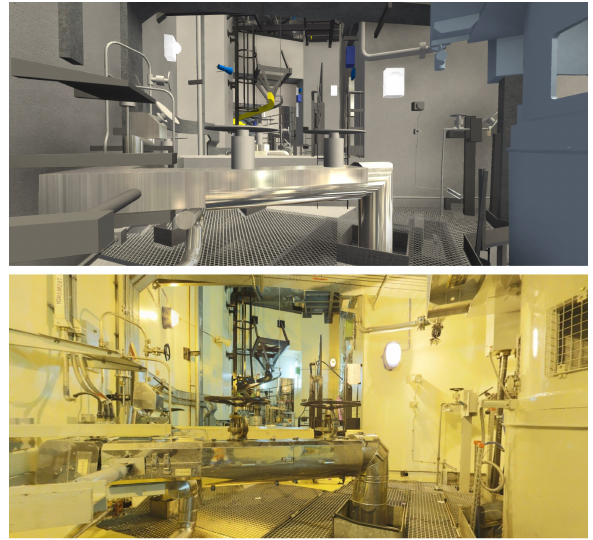
Figure 3. Data source: as-built 3D model and panoramic image accurately positioned and